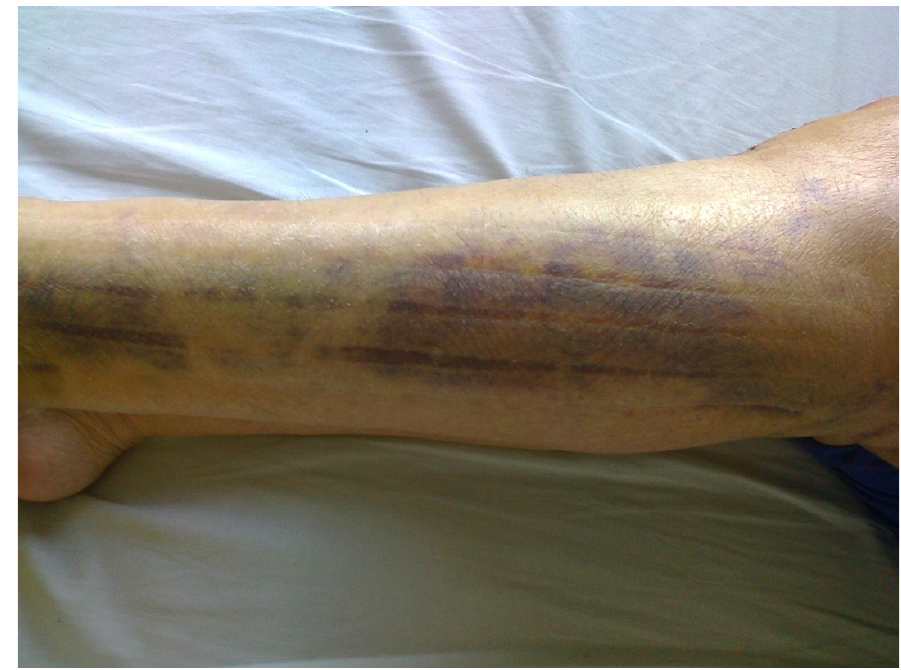
Figure 3. After eighth 24 h, KT Lymphatic application on the lower leg.